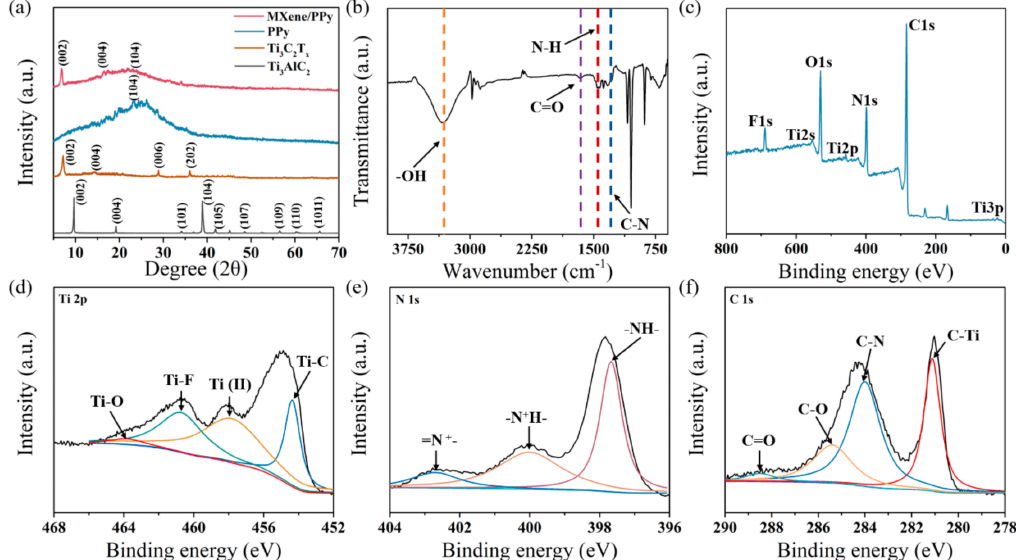
Figure 3. ( a ) The XRD patterns of Ti 3 AlC 2 -MAX, Ti 3 C 2 T x -MXene, PPy and MXene/PPy powders; ( b ) the FT-IR diagram of MXene/PPy powder; ( c – f ) the XPS spectra of MXene/PPy, Ti 2p, N 1s, and C 1s in the MXene/PPy nanocomposite,